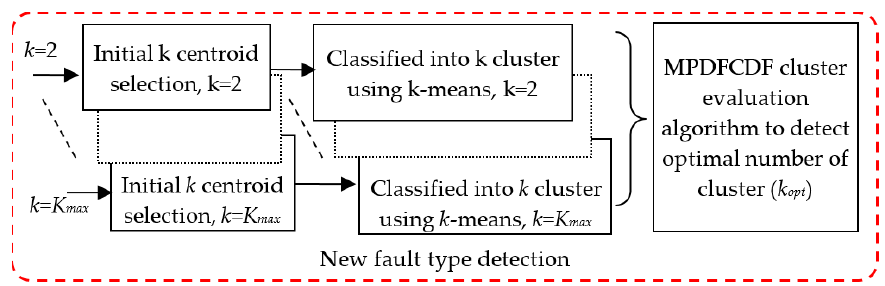
Figure 9. Proposed fault mode detection using k -means clustering and a novel cluster evaluation algorithm to detect the optimal number of clusters k. algorithm to detect the optimal number of clusters